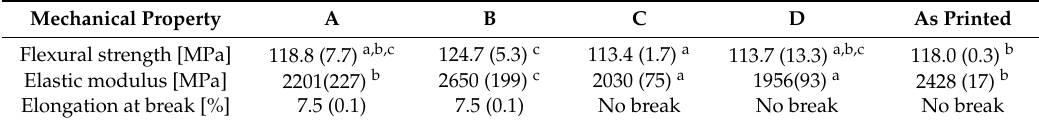
Table 8. Mechanical properties of Ultem 9085 after di ff erent ageing treatment. Superscript letters indicate statistically homogeneous subsets (Tukey’s HSD test, α =